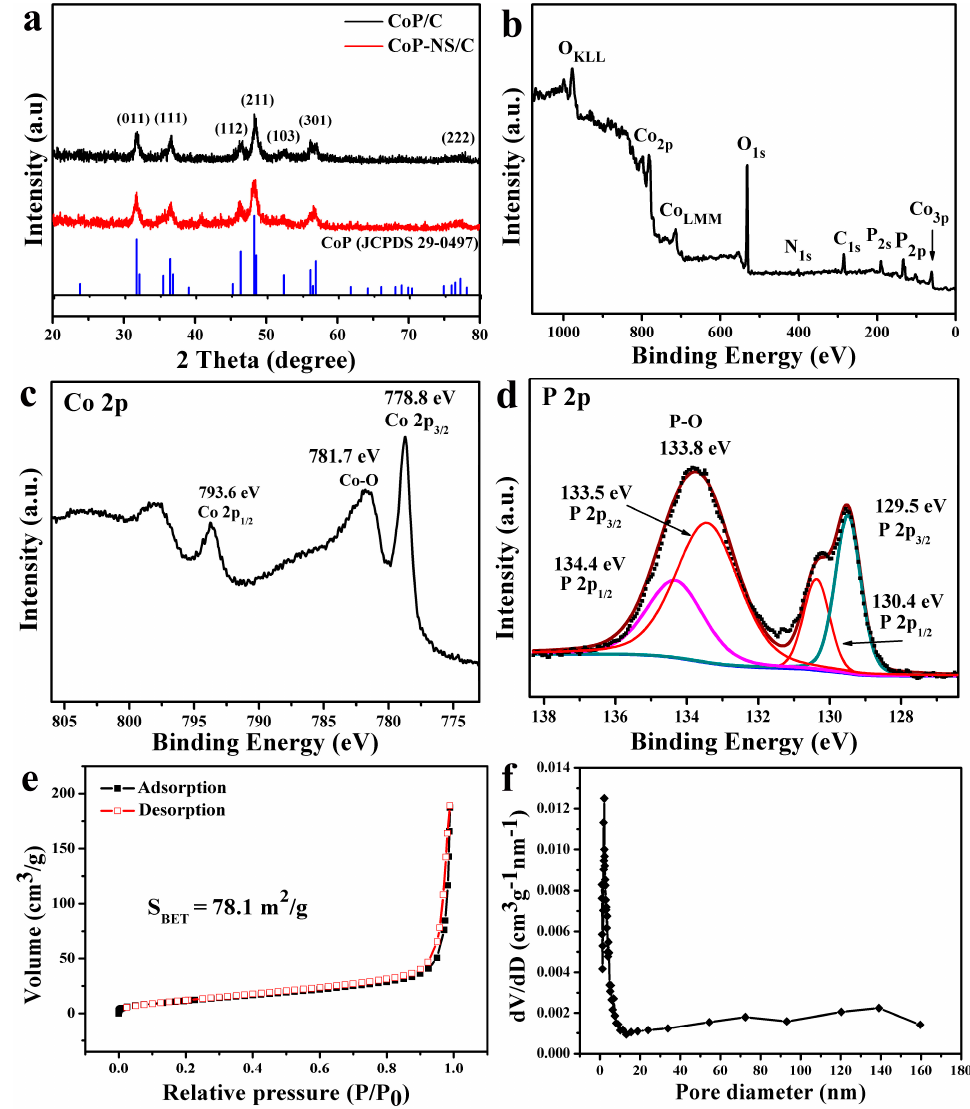
Figure 2. ( a ) X-ray diffraction (XRD) patterns of CoP/C and CoP-NS/C; ( b ) the X-ray photoelectron spectroscopy (XPS) survey spectrum; core-level spectra of ( c ) Co 2p; and ( d ) P 2p; ( e ) N 2 adsorption/desorption isotherms; and ( f ) BJH pore-size distribution curves of CoP-NS/C. The surface area was calculated using the Brunauer-Emmett-Teller method (SBET = 78.1 m 2 /g). Pore size distributions were calculated using the Barrett-Joyner-Halenda method from the desorption branch. The presence of mesopores with a size of below 20 nm is attributed to pores in the nanosheets. The pore diameter between 20 and 160 nm can be associated with the stacking pores of nanosheets. The pore volume of CoP-NS/C is 0.3 cm 3